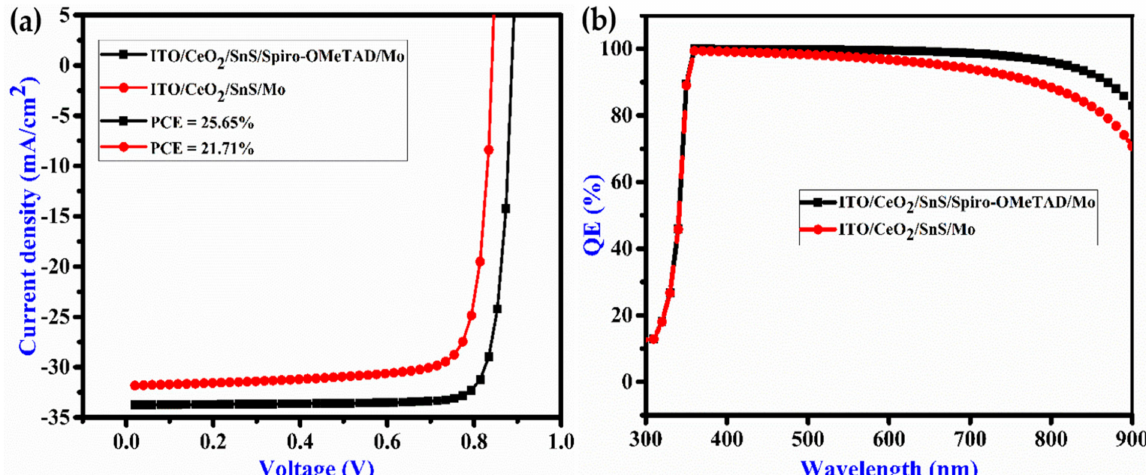
Figure 2. ( a ) J-V curve and ( b ) quantum efficiency of a proposed solar